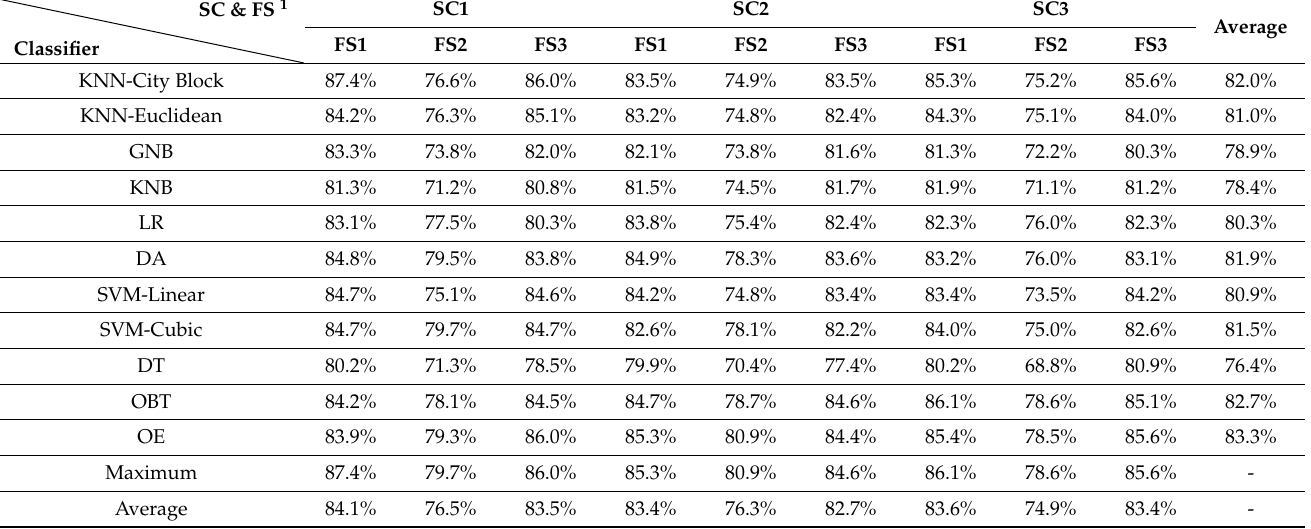
Table 6. Classification accuracies for different sensor configurations and different feature sets using different classifiers (data labeling based on